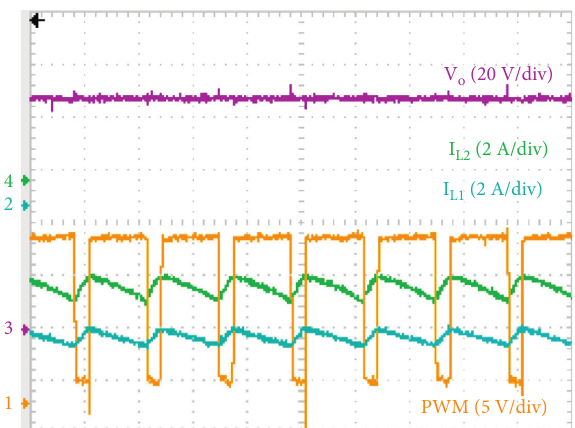
Figure 24: Buck mode operation of the converter: switching PWM (channel 1); I